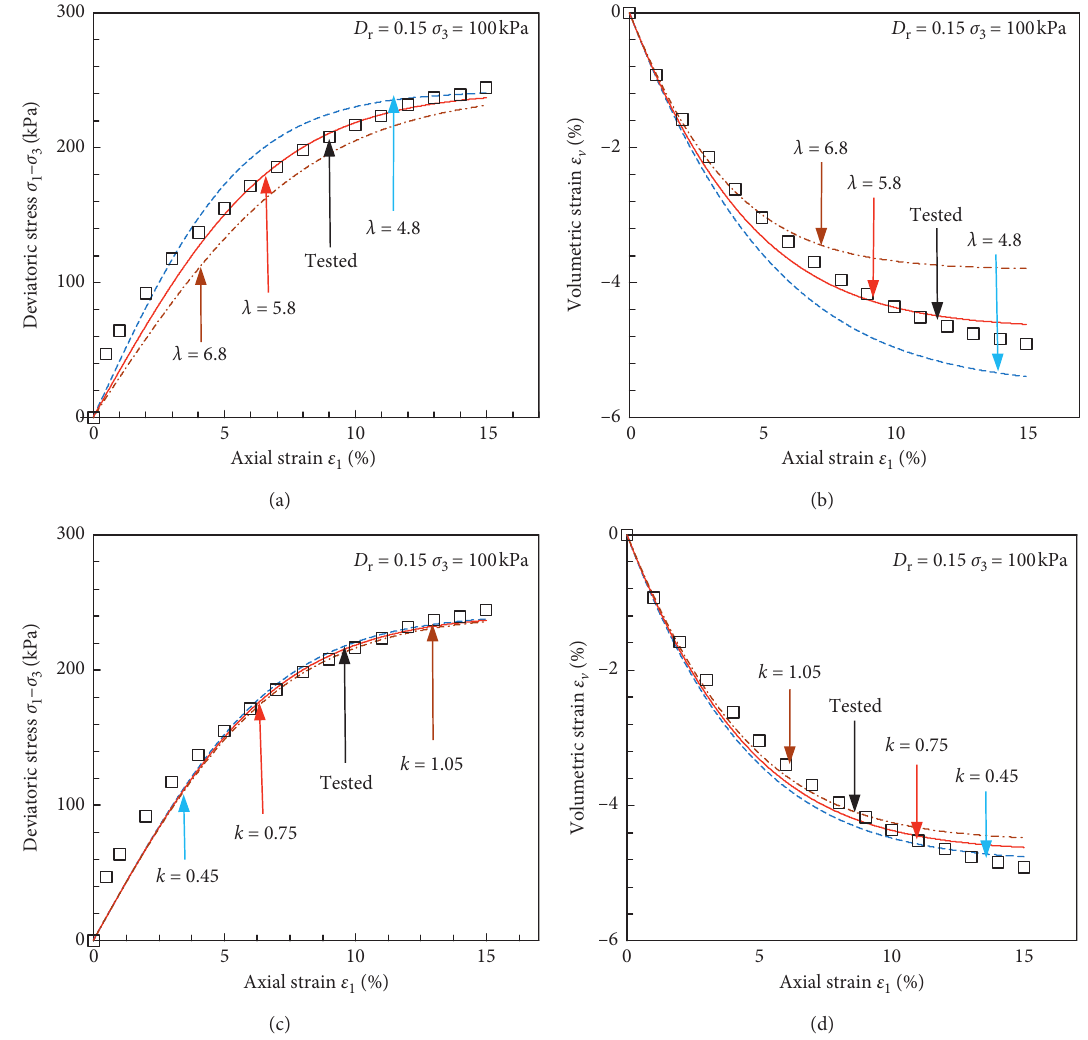
Figure 17: Effects of λ and k on the stress-strain curves and volumetric strain-axial strain curves. (a) λ -stress-strain curves. (b) λ -volumetric strain-axial strain curves. (c) k -stress-strain curves. (d) k -volumetric strain-axial strain